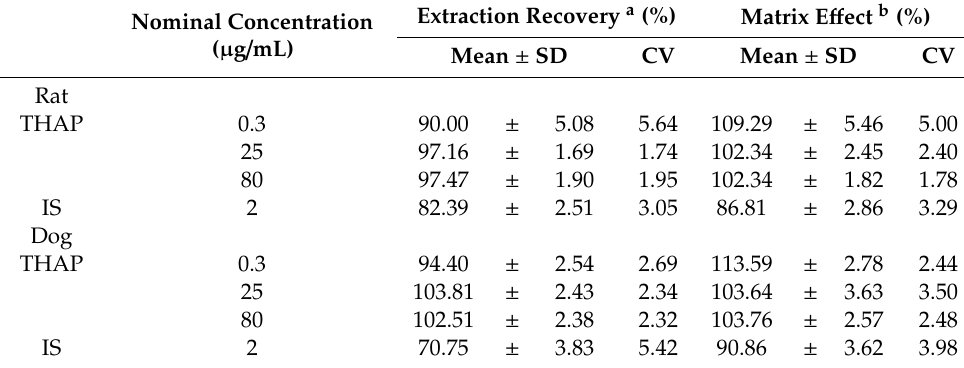
Table 2. Extraction recovery and matrix e ff ects of THAP in rat and dog plasma.